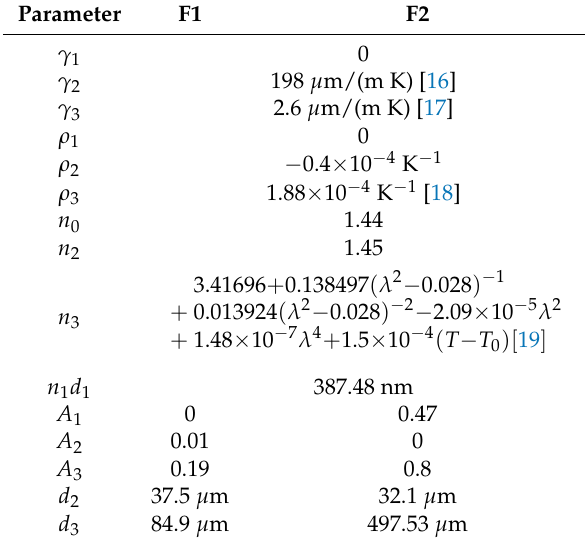
Table 2. Values of the material properties of each layer of the fabricated